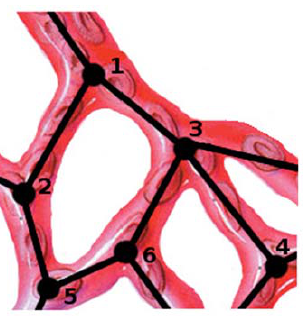
Figure 2. Schematic representation of a vascular graph. A collection of nodes i connected by edges ij